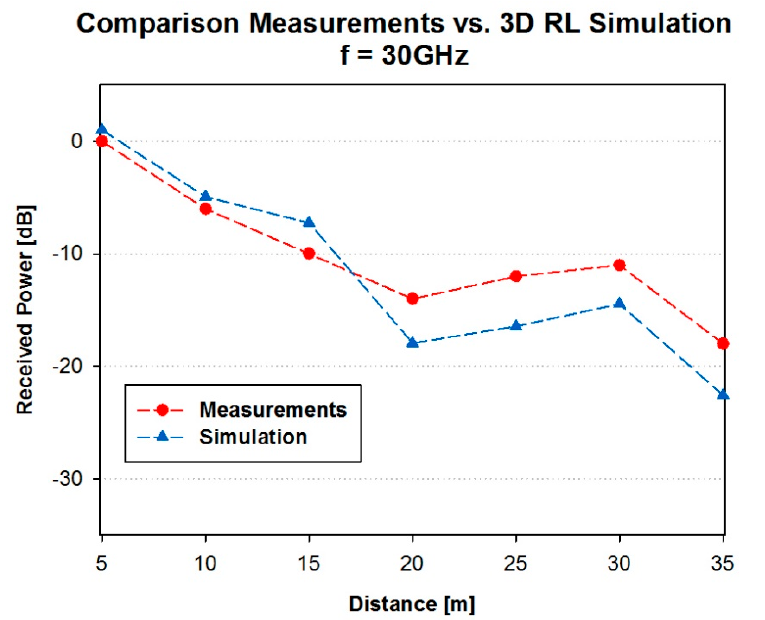
Figure 5. Comparison measurements vs. 3D-RL simulation.